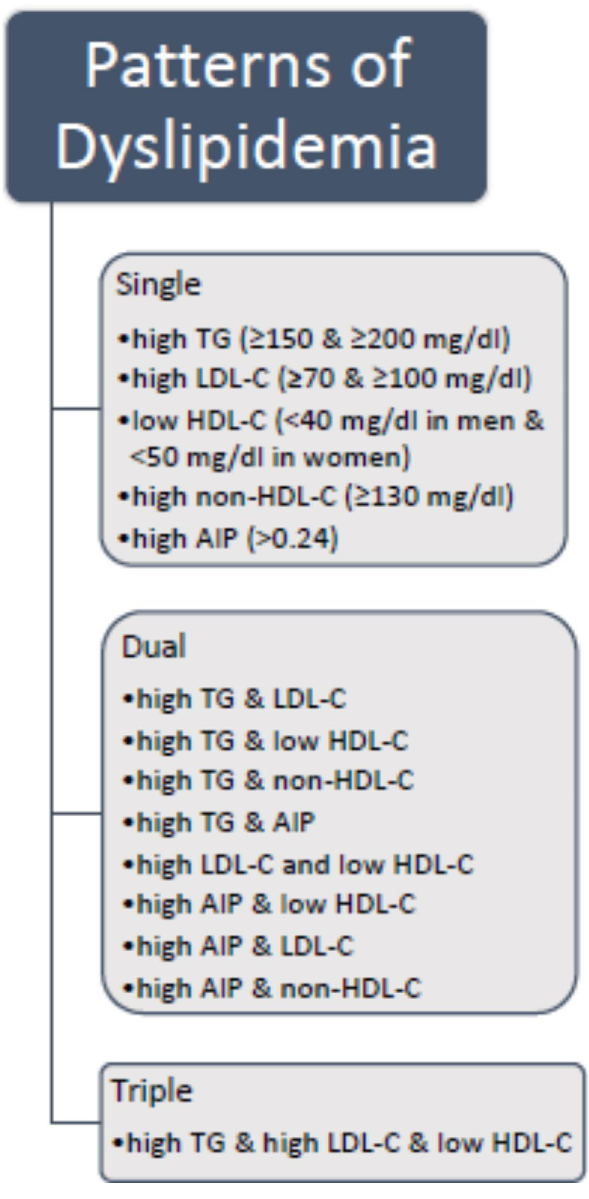
Fig. 1 Different patterns of dyslipidemia in the current study TG: triglyceride; LDL: low-density lipoprotein; HDL: high-density lipopro- tein; non-HDL: non-high-density lipoprotein (Total cholesterol minus HDL- C); AIP: atherogenic index of plasma (log